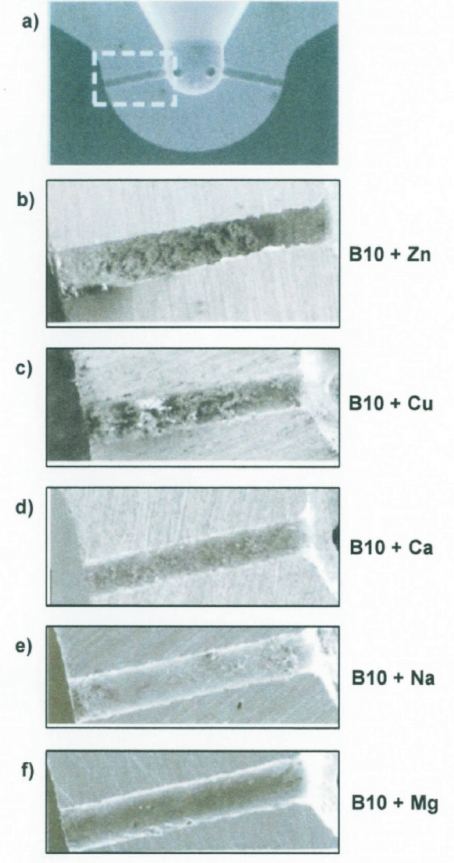
Fig. 5. Catalytic influence of different metal ions on the formation of deposits inside the fuel channels of the HPCR injectors Rys. 5. Wpływ katalitycznego oddziaływania różnych pierwiastków metalicznych na tworzenie osadów we